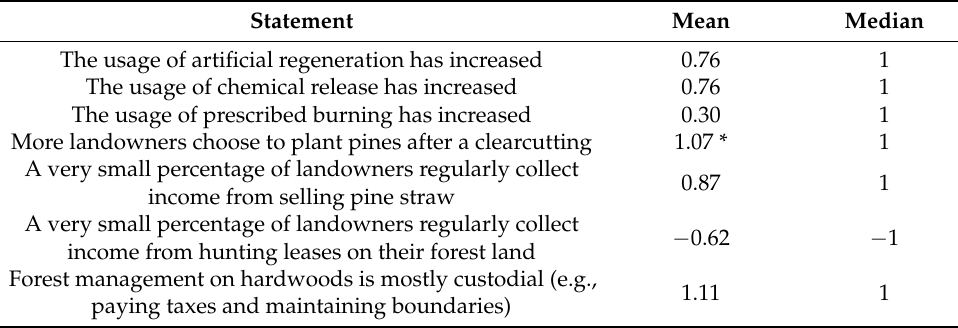
Table 6. Respondents’ average Likert-scale level of agreement with statements pertaining to current trends in forest management in their region of